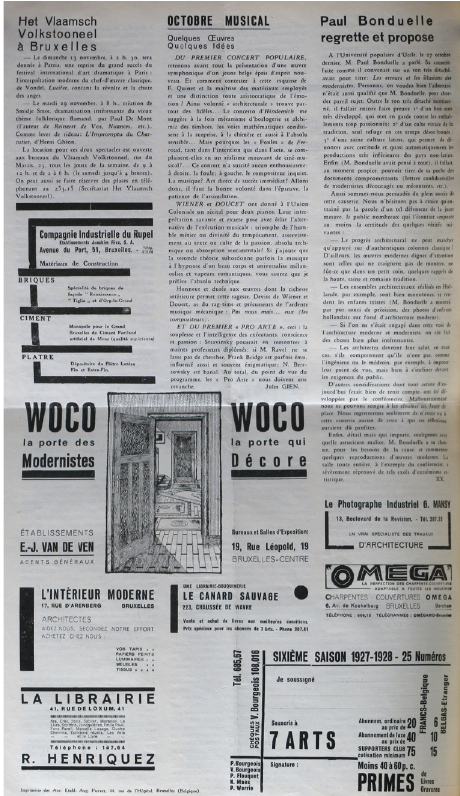
Fig. 16 7 Arts , 6th series, no. 2 (13 November 1927),